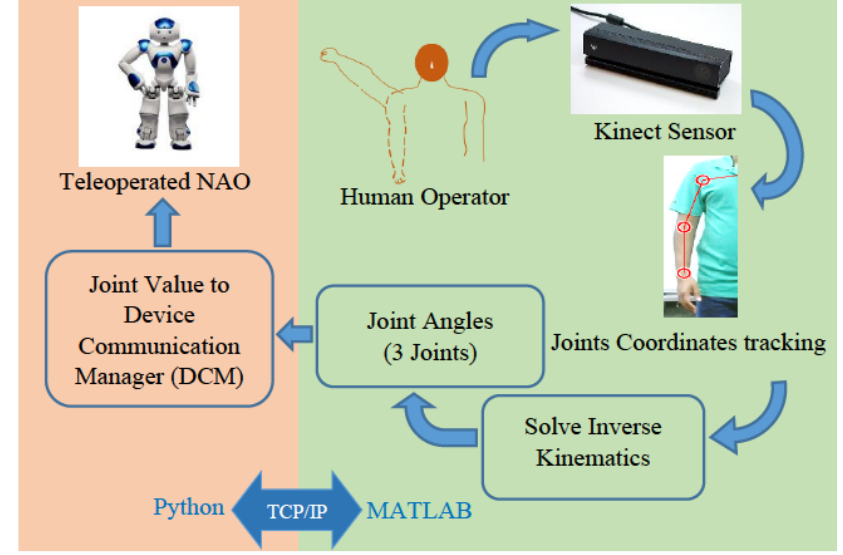
Figure 6: Schematic of the control approach